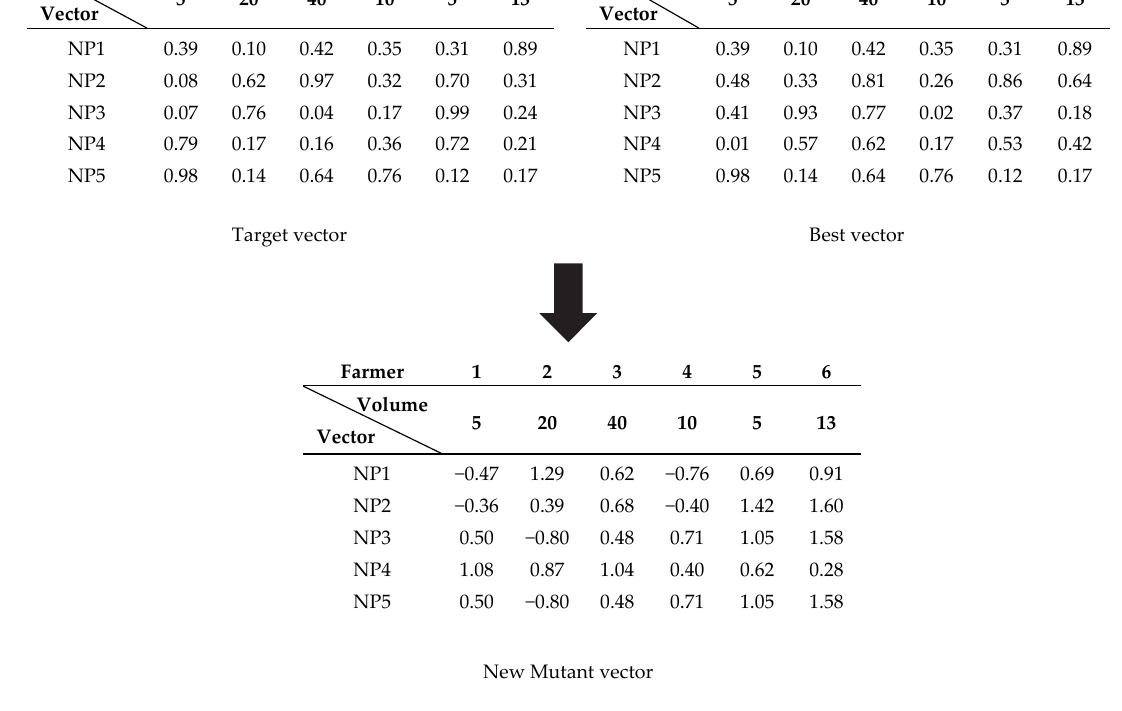
Figure 2. The modified mutant process.